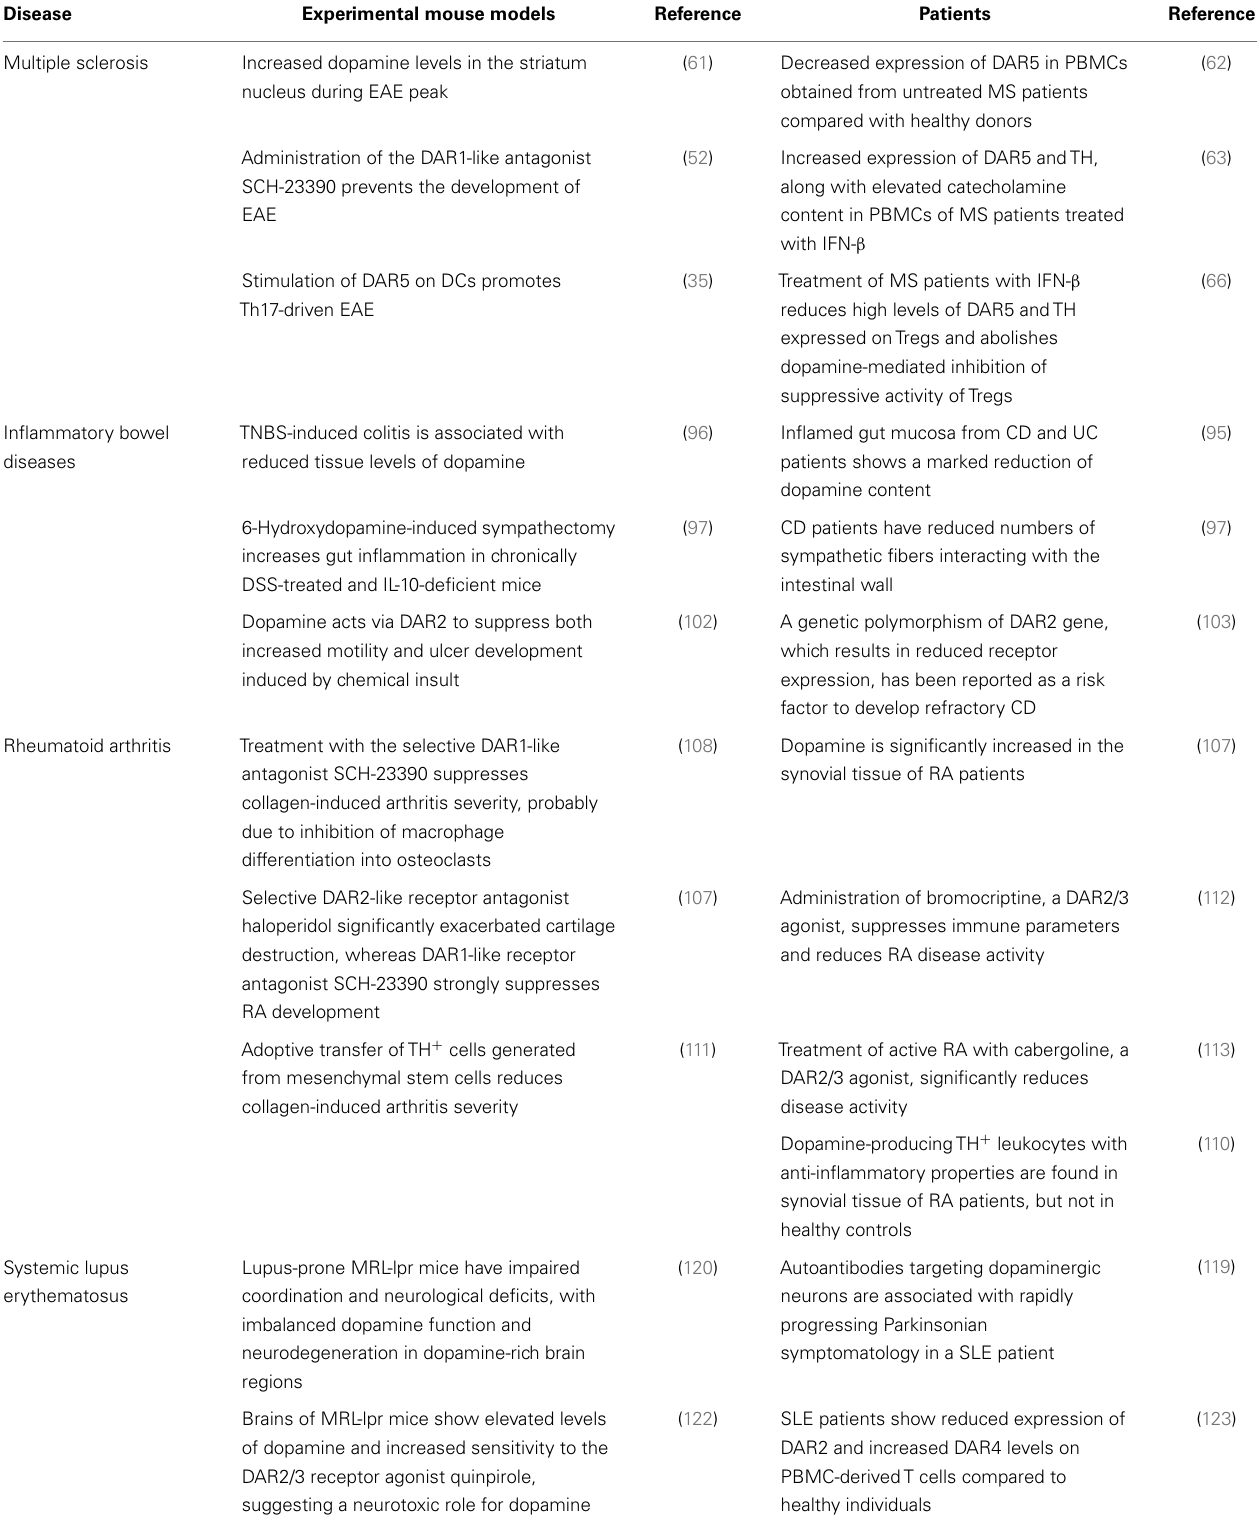
Table 1 | Observations linking the dopaminergic system with the development and progression of autoimmune disease